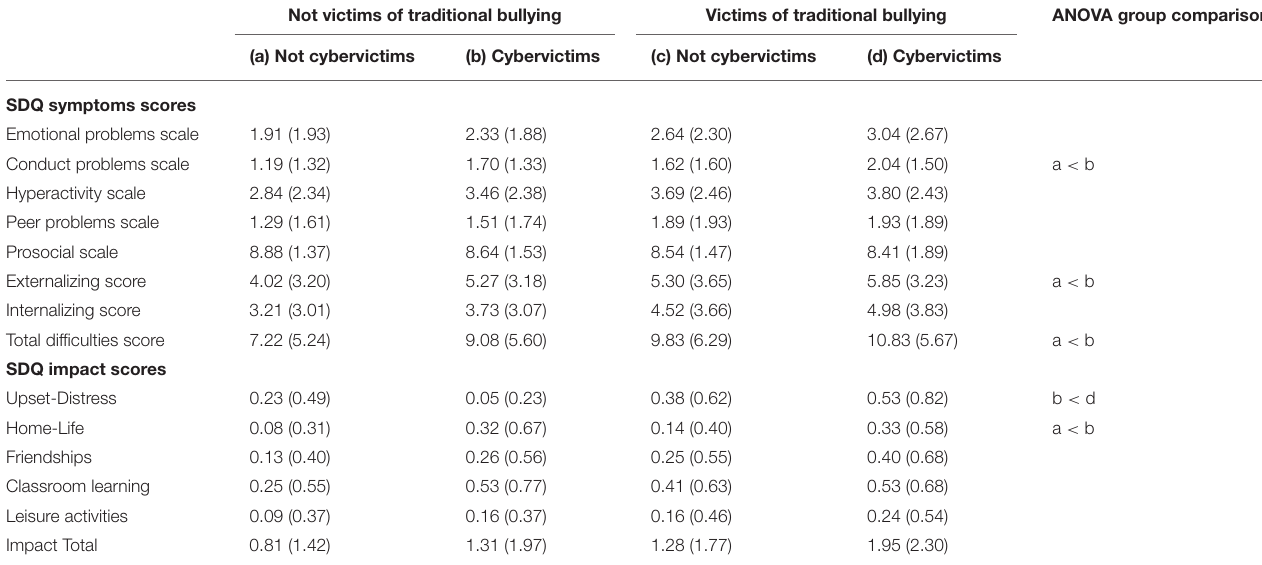
TABLE 1 | Comparison of means (and SD) between cybervictims and non-cybervictims among victims and non-victims of traditional bullying. Not victims of traditional bullying Victims of traditional bullying ANOVA group